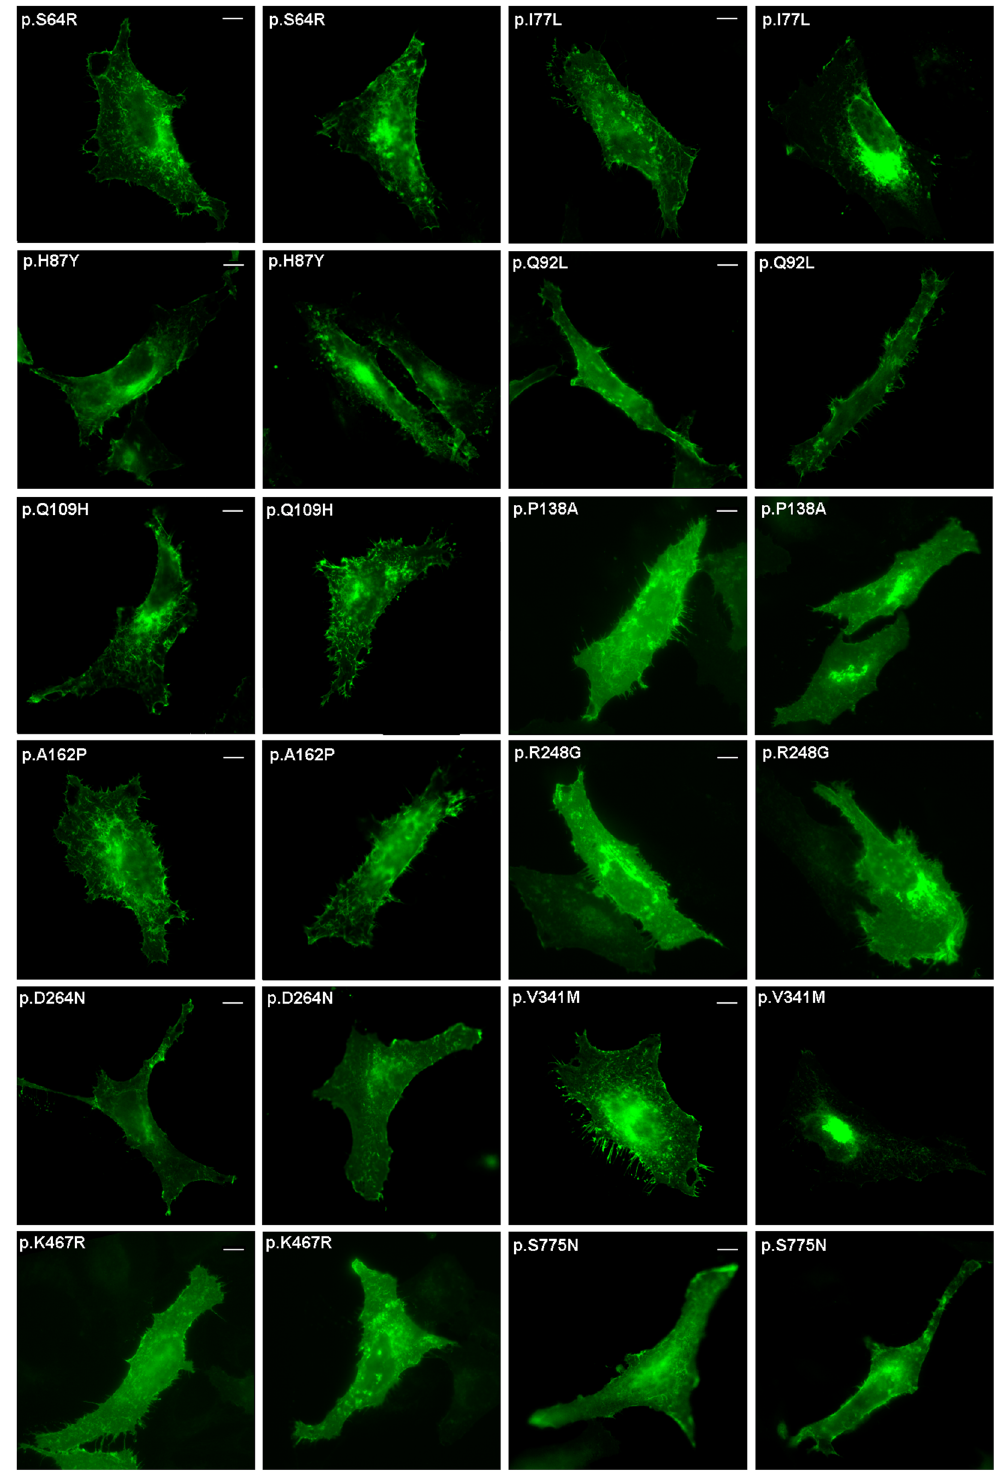
Figure 7. Representative photomicrograph showing subcellular localization of the BMPR2 mutants which pattern of expression is not altered. All these constructs are GFP-tagged at the C-terminus. After 24 h post- transfection, HELA cells were fixed and mounted in Fluoromount-F. Images were visualized using a Leica TCS SP2 confocal system. The scale bar is 10 μ